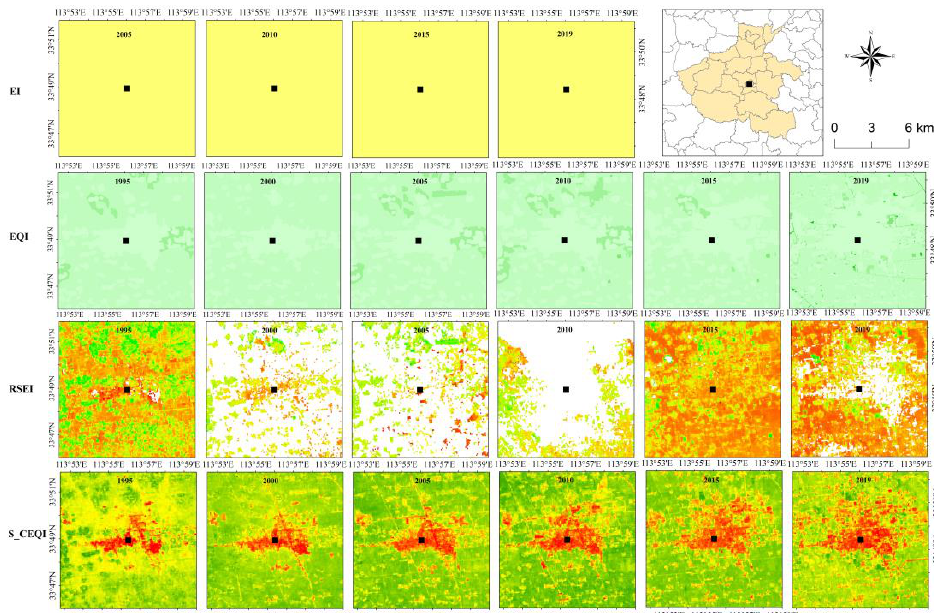
Figure 8. Spatial resolution of models ( EI , EQI , RSEI , S CEQI Figure 8. S pa tial resolution of models (EI, EQI, RSEI, S_CEQI) . Profile Analysis